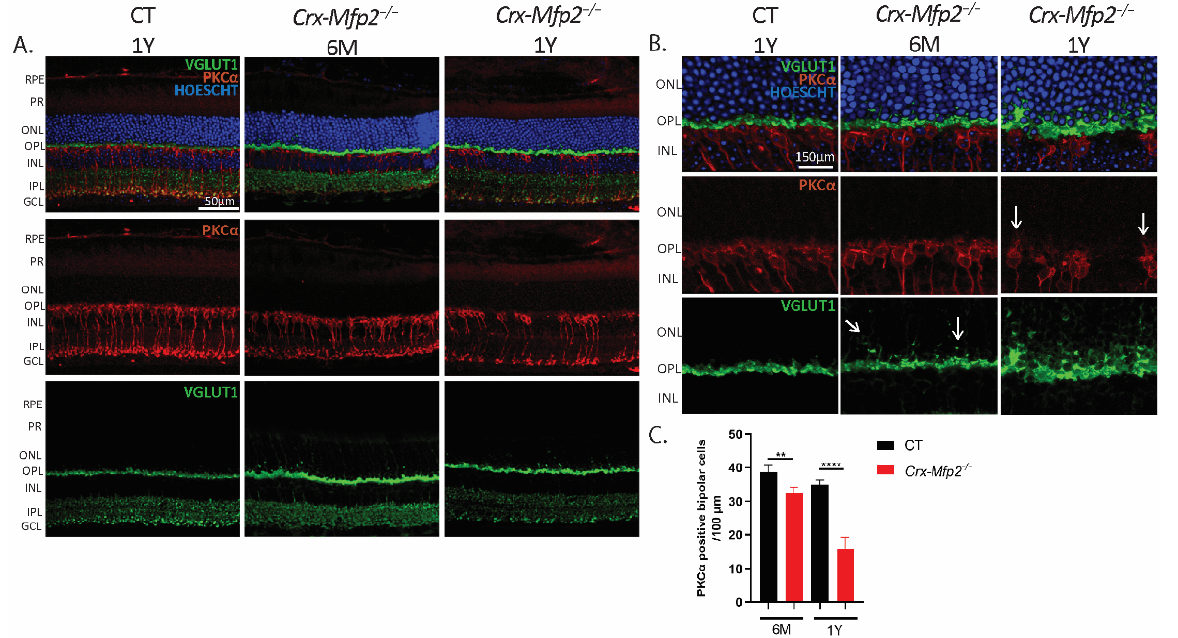
Figure 5. Crx-Mfp2 − / − mice show loss of bipolar cells and impaired synaptic connections. ( A ) PKC α (red) staining showed clear loss of bipolar cells at the age of 1 Y. ( B ) Higher magnification images revealed sprouting of bipolar cells (red) and VGLUT1 (green) mislocalization into the ONL. White arrows indicate the sprouting. ( C ) Quantification of PKC α positive bipolar cells per 100 µ m revealed a significant loss in both 6-month-old and 1-year-old Crx-Mfp2 − / − mice. N = 4/group. Statistical difference based on unpaired t -test: ** p < 0.01, **** p < 0.0001. Error bars indicate SD. RPE—retinal pigment epithelium; PR—photoreceptor; ONL—outer nuclear layer; OPL—outer plexiform layer; INL—inner nuclear layer; IPL—inner plexiform layer; GCL—ganglion cell layer.